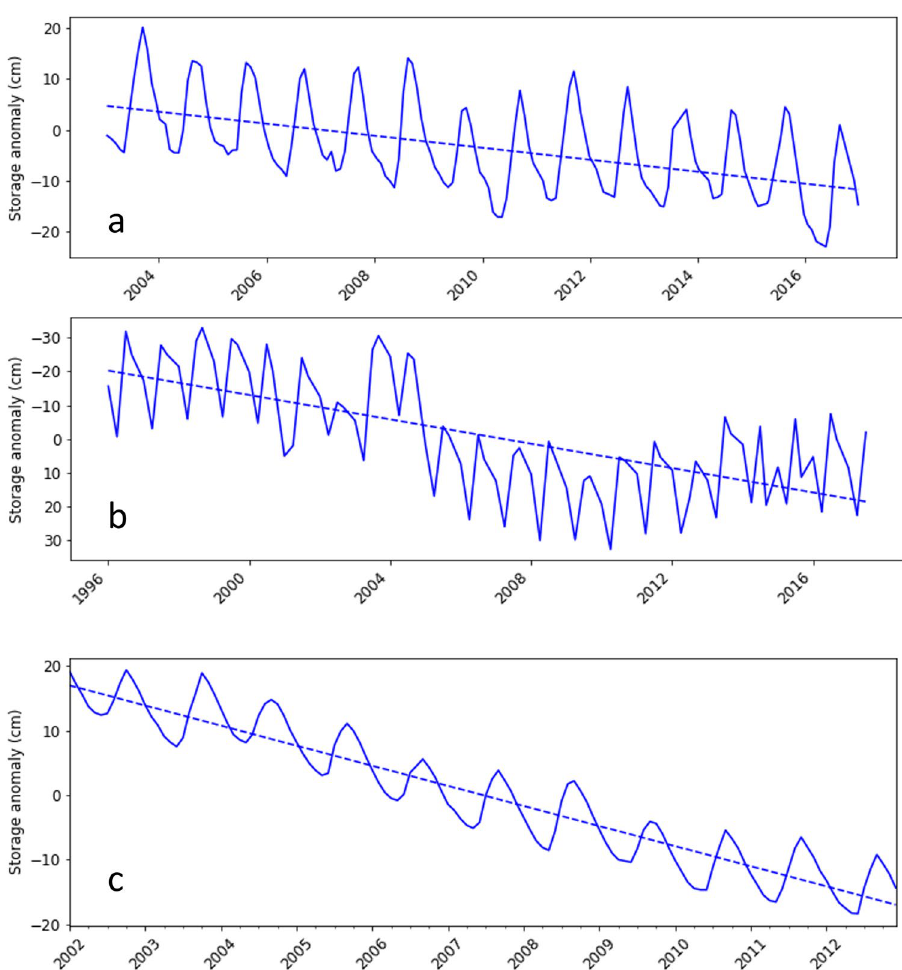
Figure 9. Trends in storage anomaly estimated from ( a ) GRACE derived groundwater storage anomaly ( b ) observed groundwater level depth to water table ( c ) simulated groundwater storage